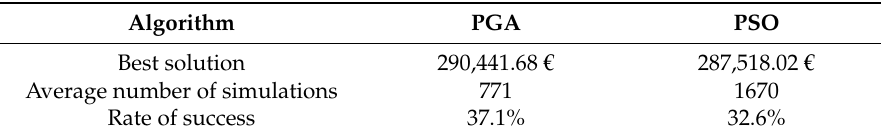
Table 5. Summary of results for both